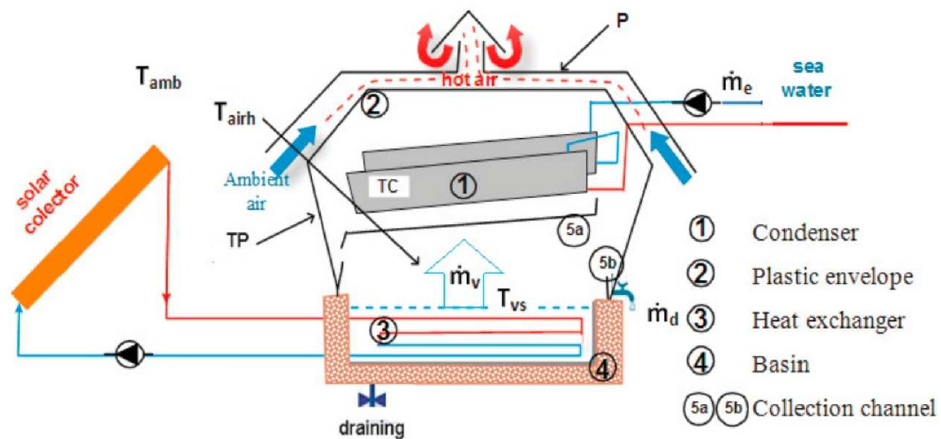
Figure 10. Schematics of a laboratory-size single-stage solar HD system [190].